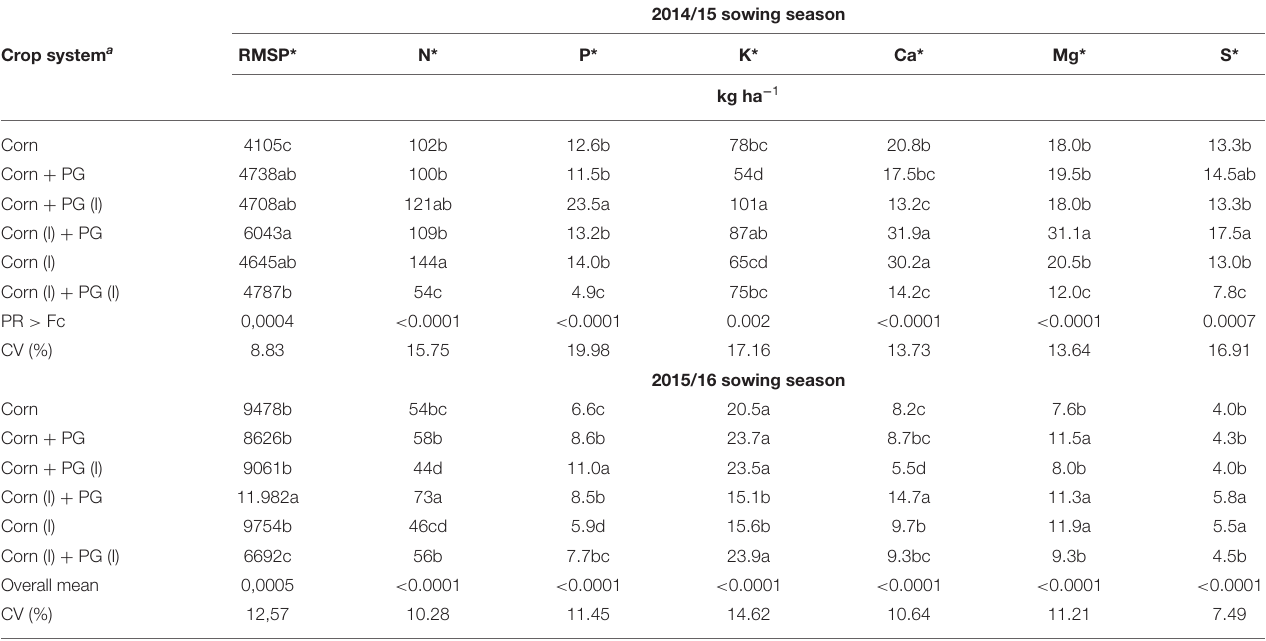
TABLE 4 | Remaining corn straw production (RMSP) and nutrient accumulation in corn straw in 2014/15 and 2015/16 sowing seasons.